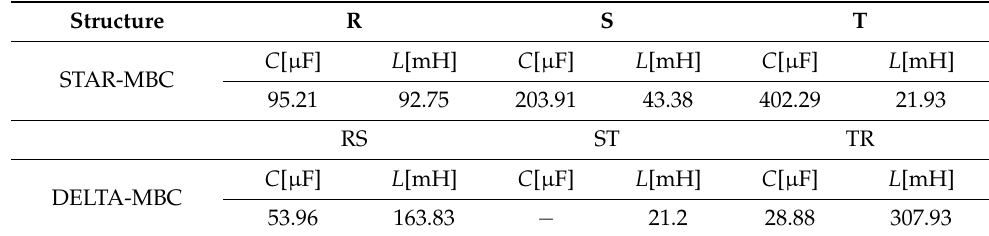
Table 5. List of the values of the reactive elements for the minimizing balancing compensators.